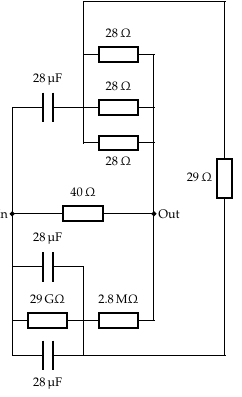
Figure 2. The final circuit from the chromosome from Table 4.